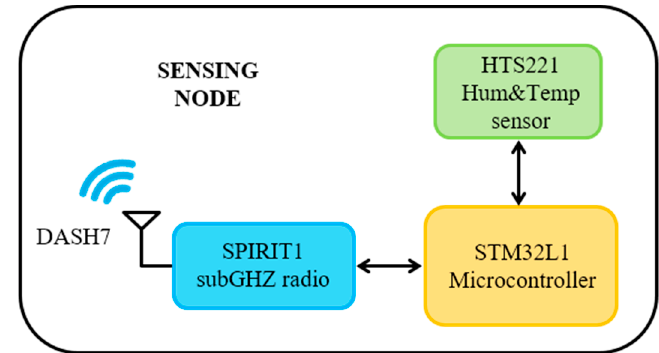
Figure 9. Block diagram of the sensing node.